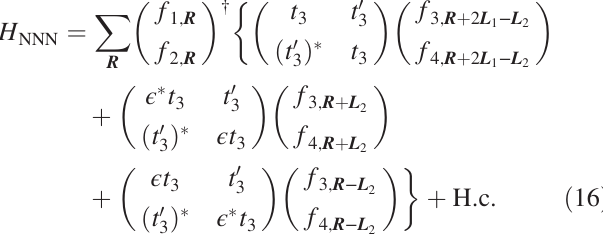
and w 3 . The number outside (inside) the parentheses is for WSs obtained from the ; 2 ; 4